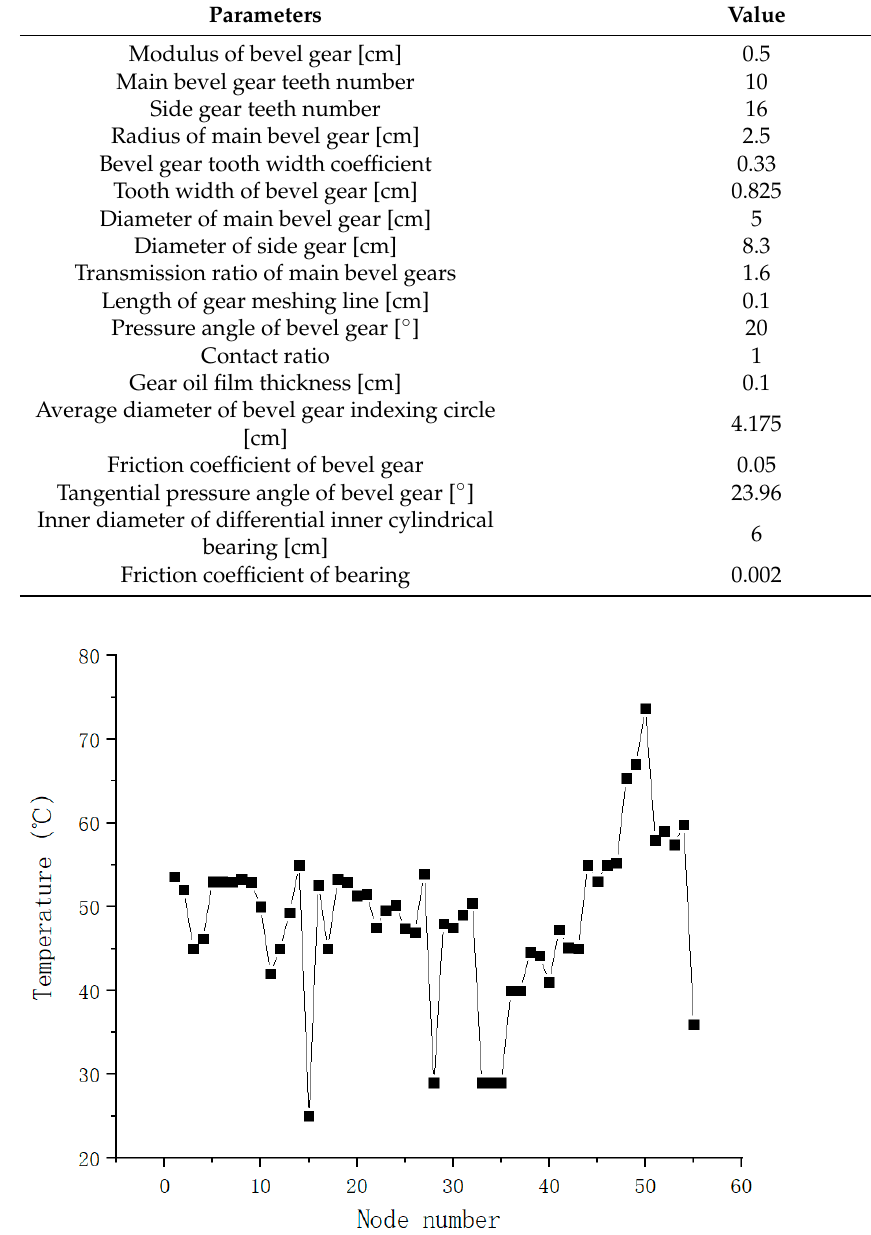
Table 4. Parameters of the differential.